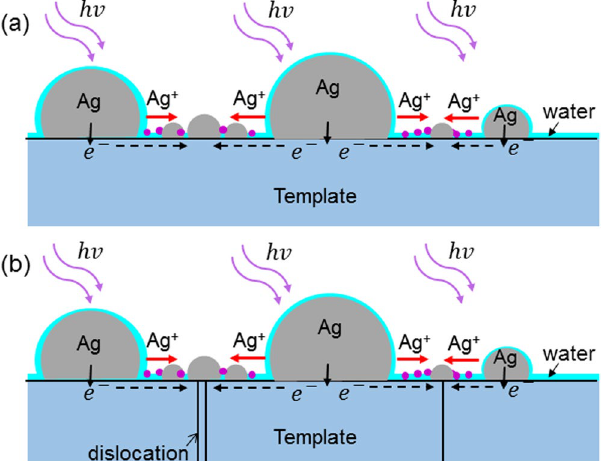
Figure 6. ( a ) Schematic demonstration of Ag NP reorganization mechanisms. ( b ) Schematic demonstration similar to part ( a ) except that threading dislocations are added for affecting electron transporting